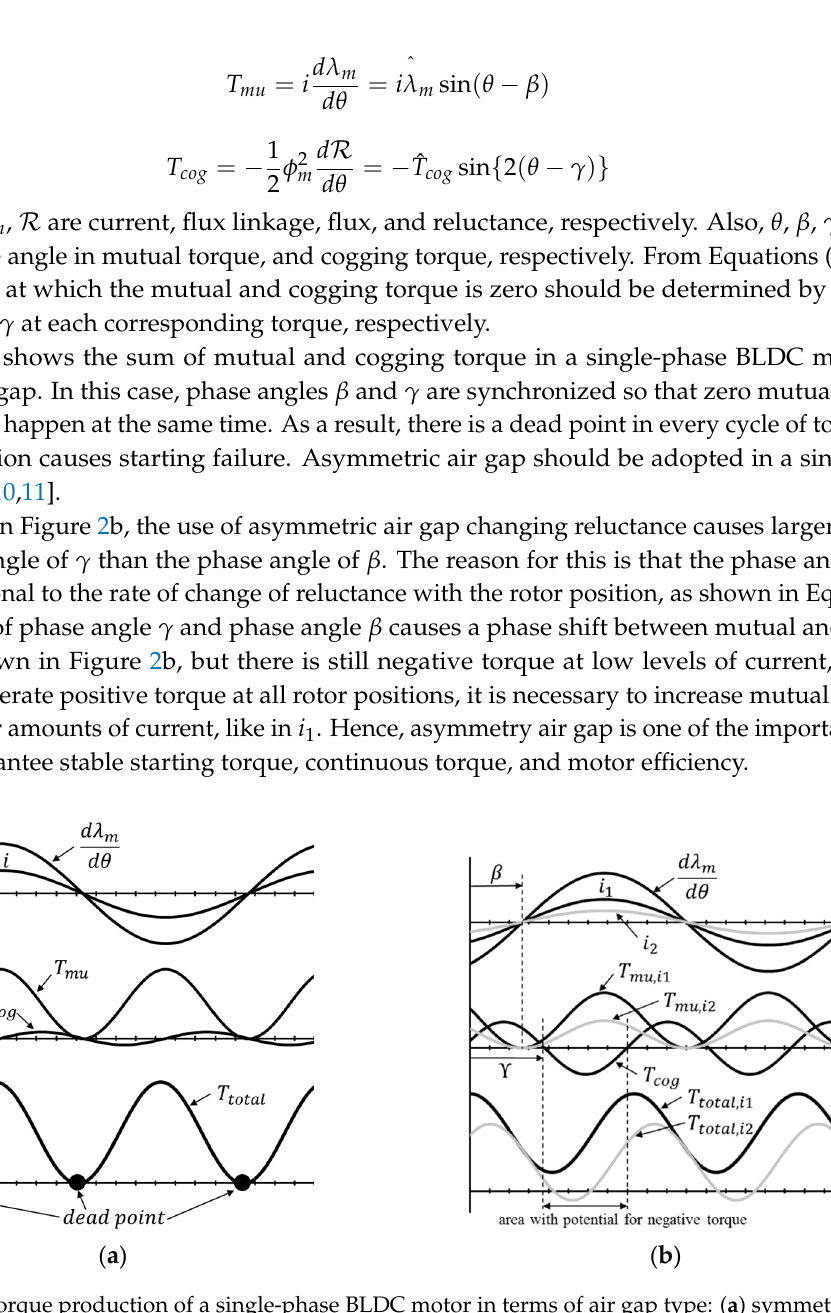
Figure 2. Torque production of a single-phase BLDC motor in terms of air gap type: ( a ) symmetric air gap; ( b ) asymmetric air gap.